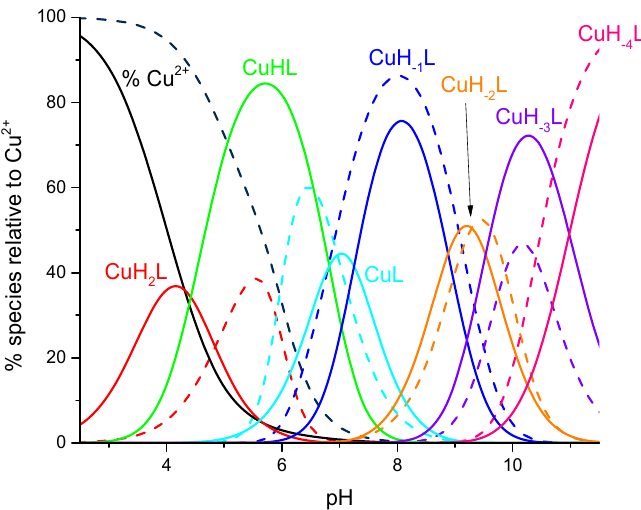
Figure 1. The species distribution curves for the system of L1 − c(GlyHisProHisLys) (solid line) and L2 − c(GlyHisGlyHisLys) (dashed